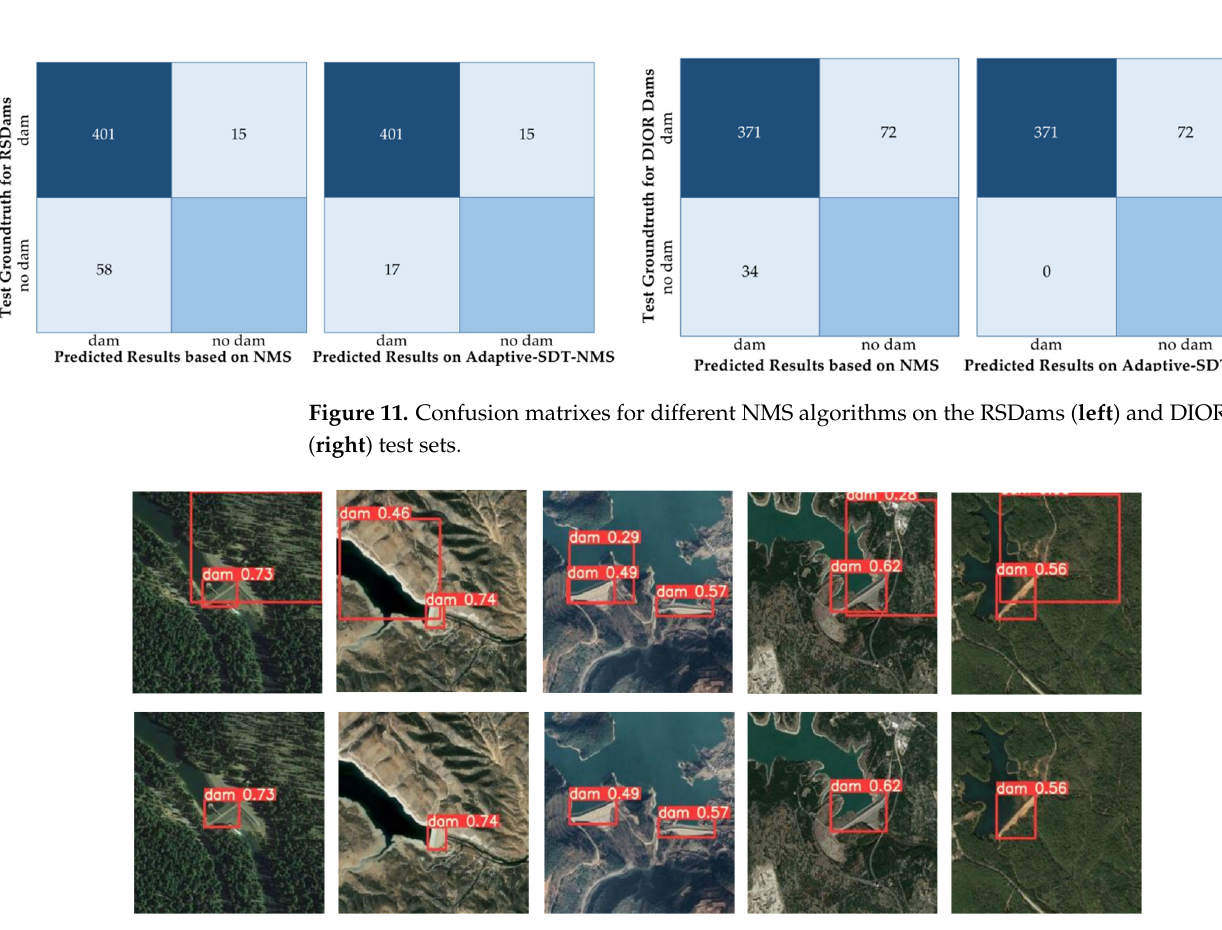
Figure 12. Comparison of the post-processing results for the NMS and Adaptive-SDT-NMS algo- rithms. The examples in the first row contain the false positives of the original NMS of YOLOv5s, and the second row shows the real positive cases from the Adaptive-SDT-NMS